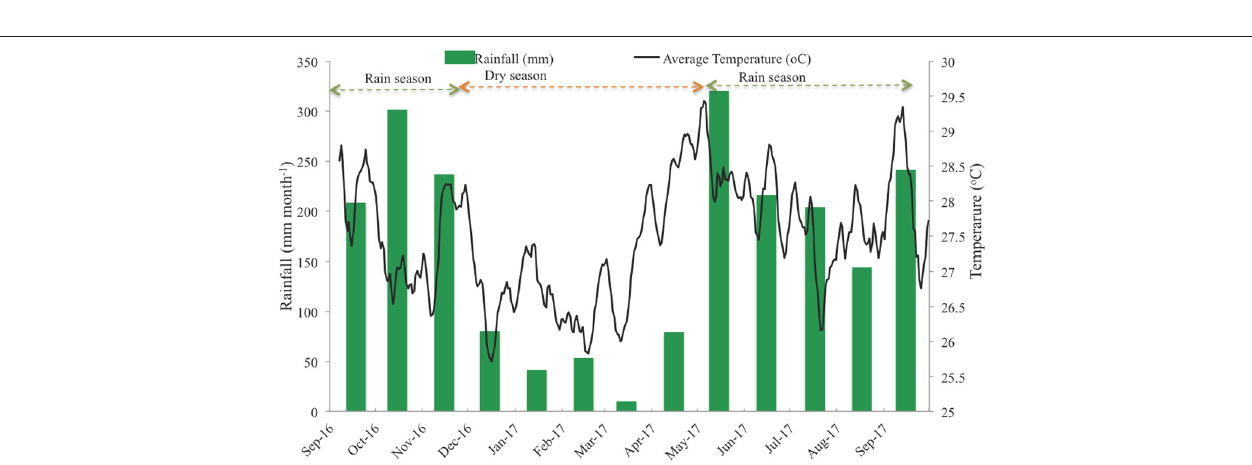
FIGURE 1 | Study sites location: (A) Can Gio mangrove forest (in dark green color) in Southern Vietnam, (B) positions of the Rhizophora stand and the Avicennia stand studied.